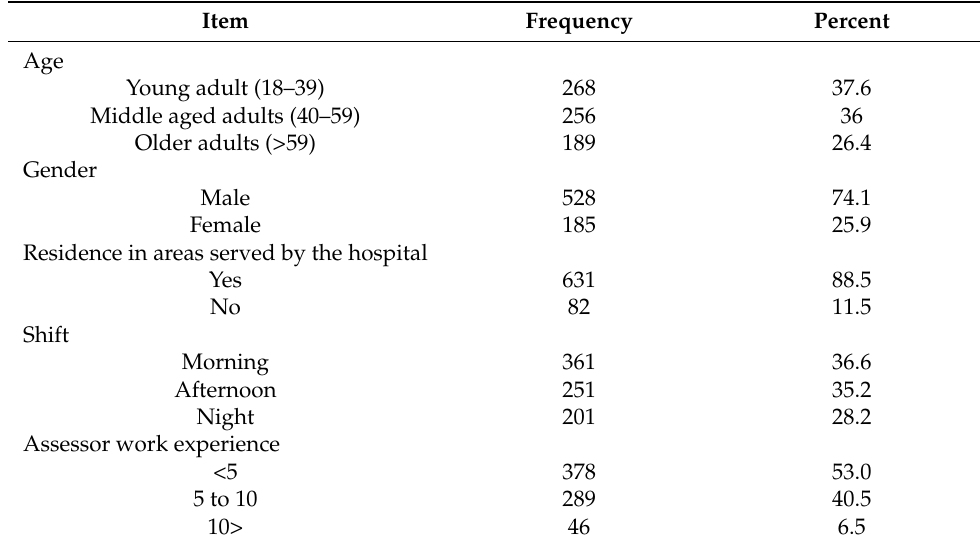
Table 2. Patient and assessor demographic data.